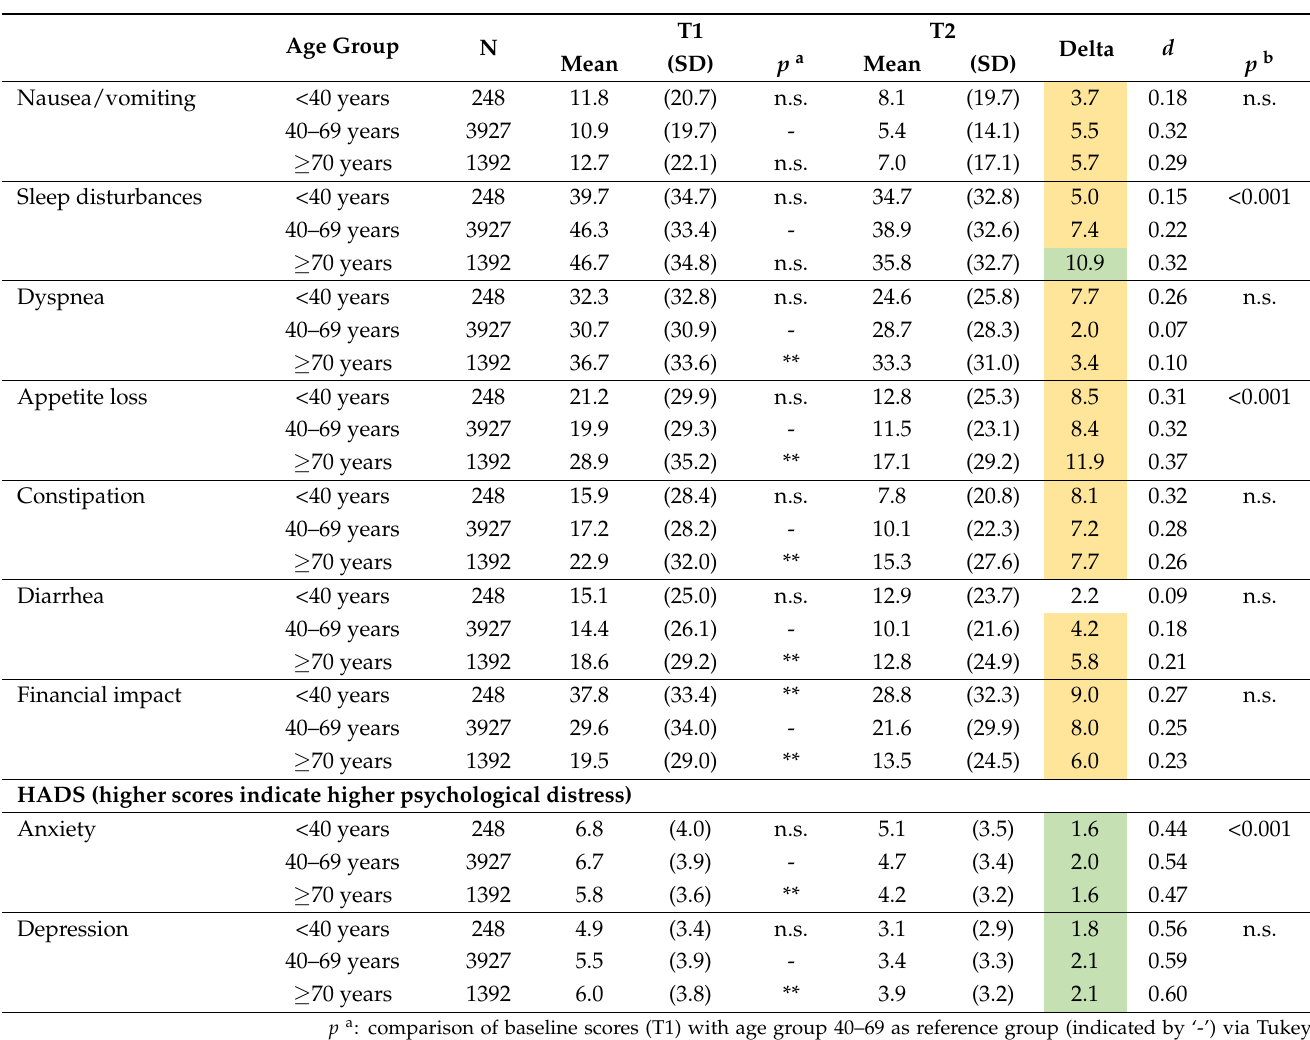
p a : comparison of baseline scores (T1) with age group 40–69 as reference group (indicated by ‘-’) via Tukey HSD test; n.s.: not significant; **: significant at p < 0.001 after correction for multiple testing; d : Cohen’s d . mean